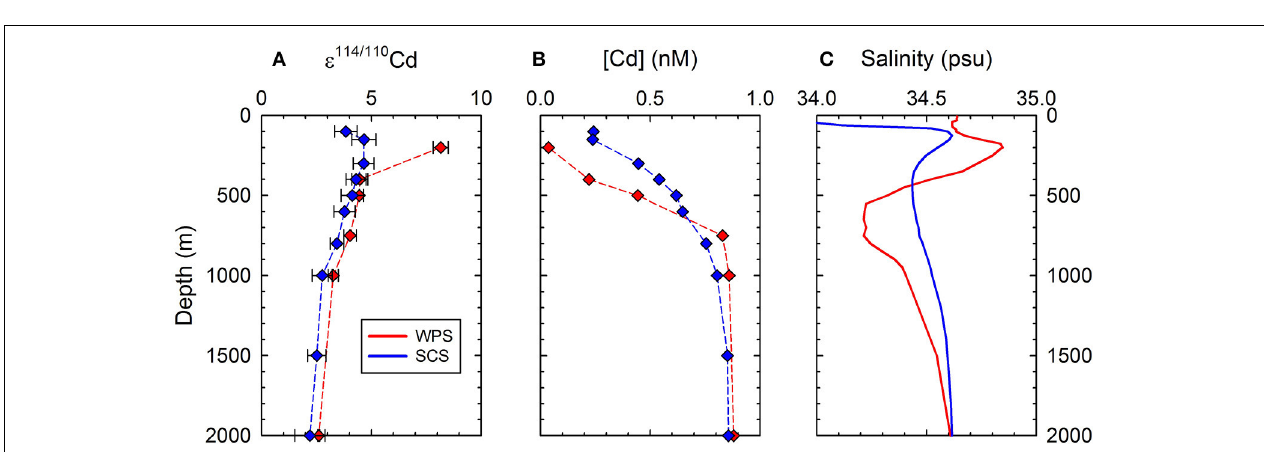
FIGURE 5 | Depth profiles of Cd concentrations, ε 114 / 110 Cd and salinity in the thermocline and deep water of the West Philippine Sea (200–2000m) and South China Sea (100–2000m). (A) ε 114 / 110 Cd values; (B) Cd concentrations; (C) salinity. The data of SCS is quoted from Yang et al. (2012).